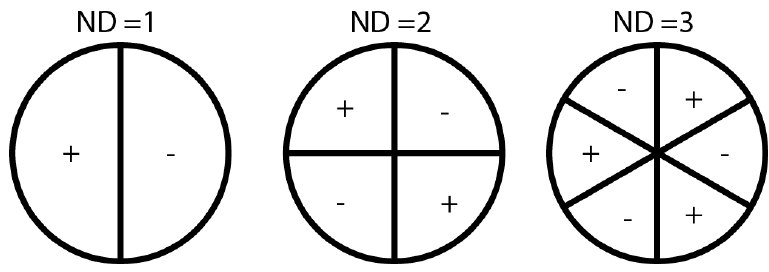
Figure 2. Disks vibrating with one, two and three nodal diameters, respectively.